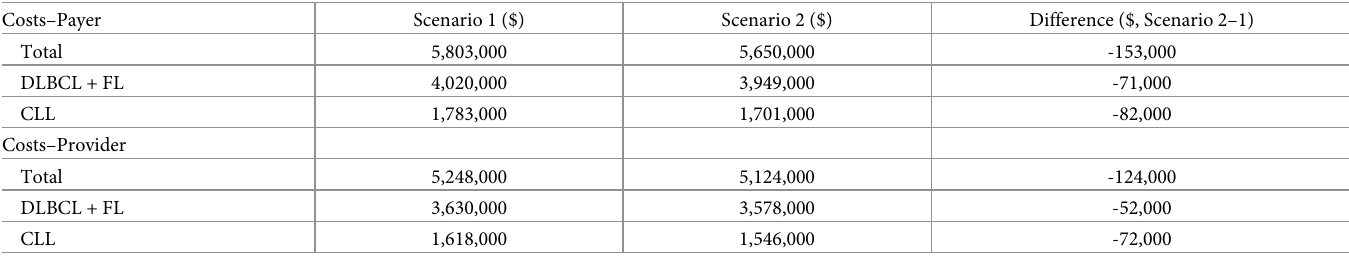
Table 2. Base-case results.